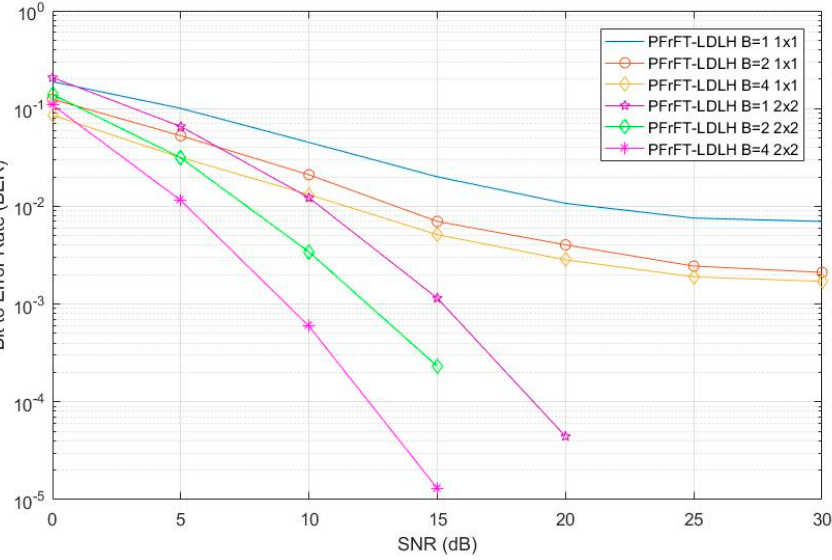
Figure 8. BER performance for with SISO ‐ PFrFT and MIMO ‐ PFrFT.